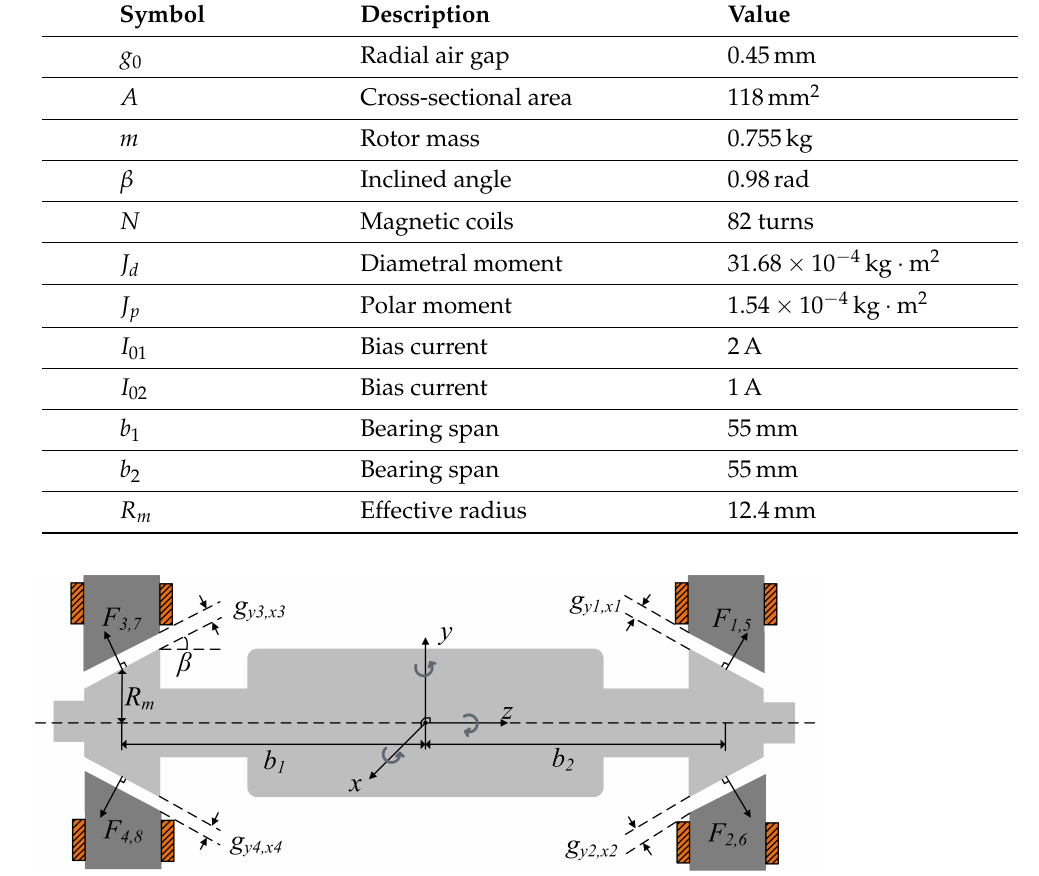
Figure 2. Schematic of conical active magnetic bearing